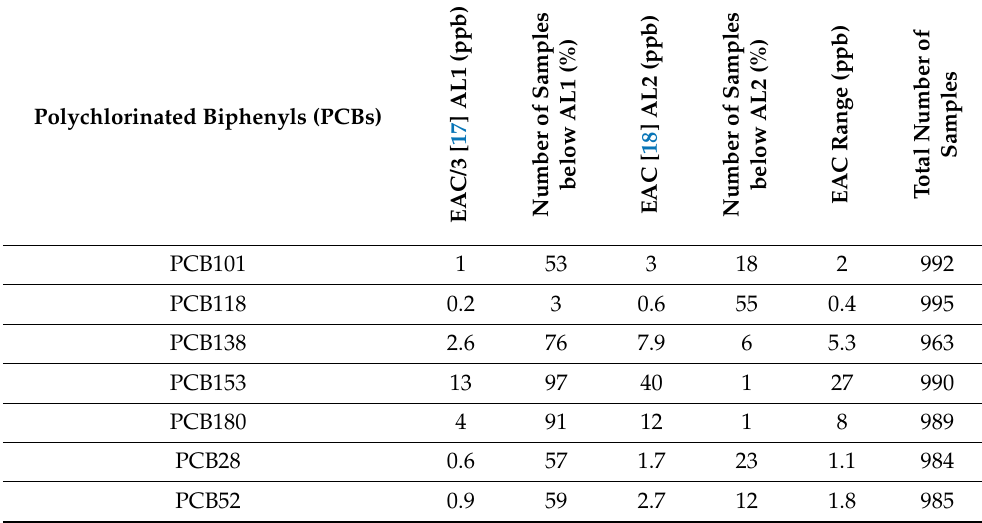
Table 16. Polychlorinated biphenyls (PCBs)—Individual PCBs (EACs) [18]—Percentage of samples below AL1; above AL2; and range.